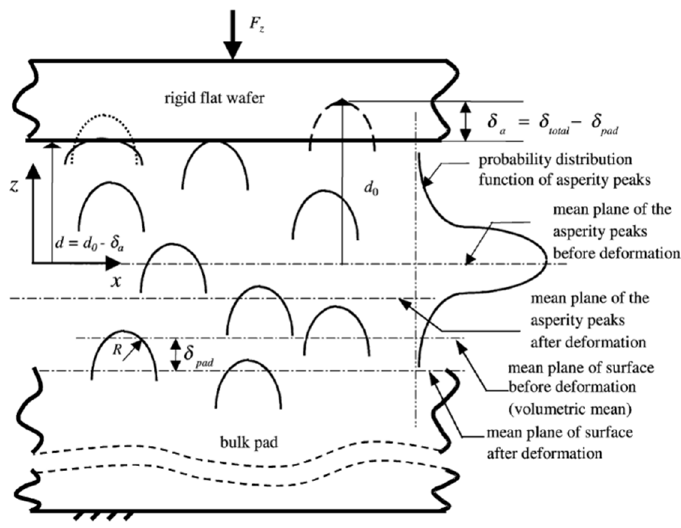
Figure 12. Asperities on a rough surface in contact with a rigid flat surface [30].